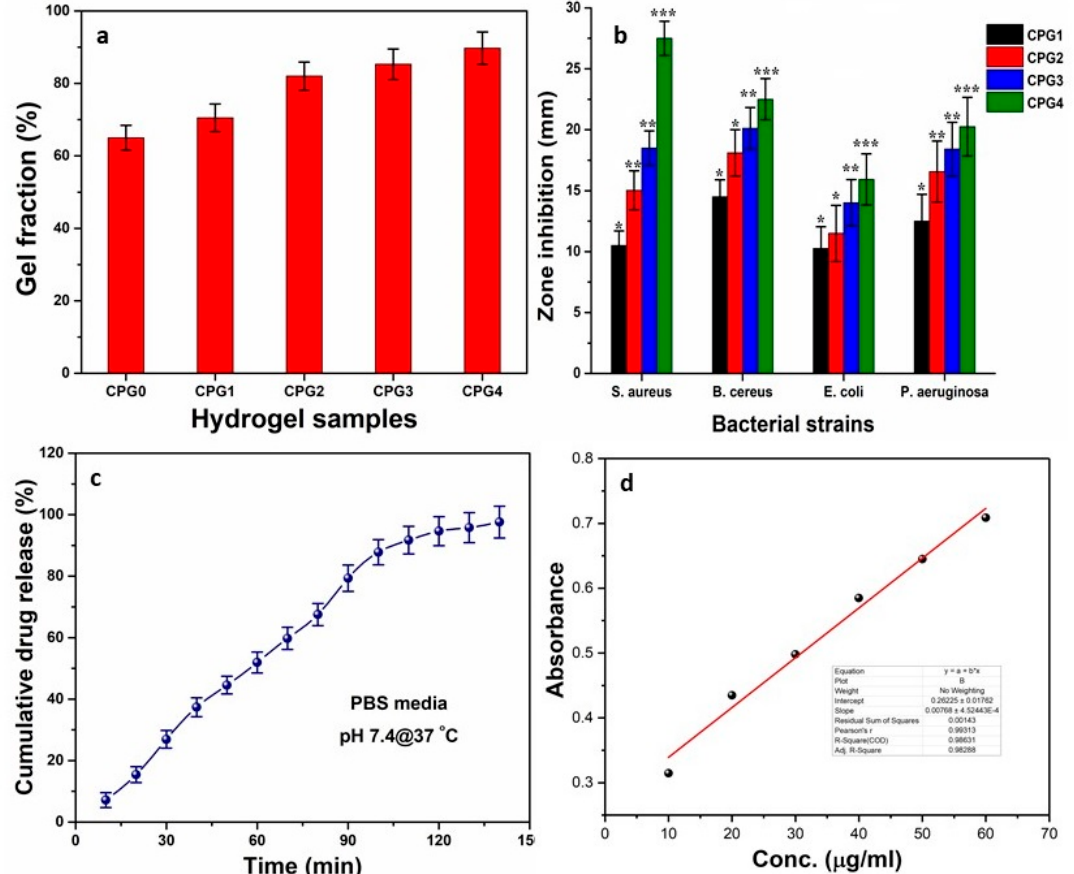
Figure 5. ( a ) Percentage of gel fraction ( b ) zone inhabitation against Gram positive ( S. and B. cereus ) and Gram negative ( P. aeruginosa and E. coli ) bacterial strains, ( c ) cumulative release (%) of paracetamol from CPG2, ( d ) standard curve of paracetamol at 243 nm. (* p < 0.05, ** p < 0.01 and *** p < 0.001 and n = 3.)